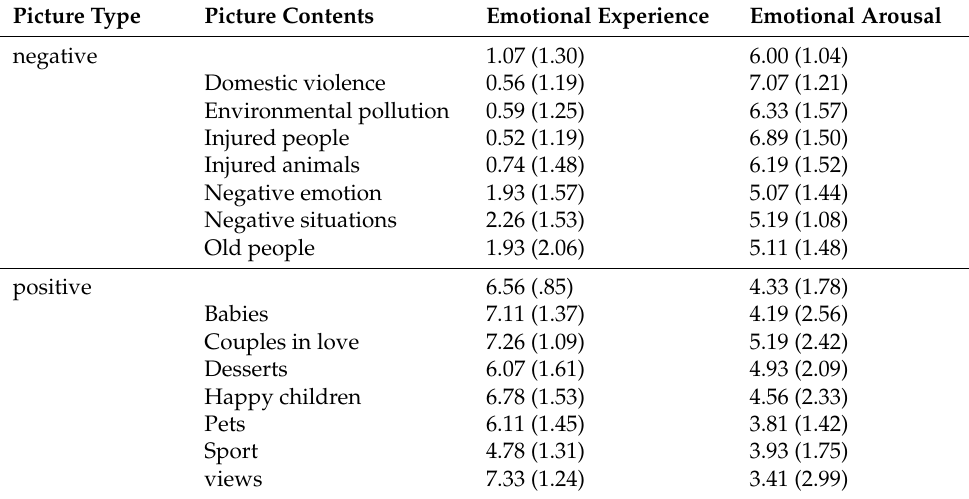
Table 10. Means and standard deviations (SD) of the subjective ratings of emotional experiences and emotional arousal in response to picture type and picture content (N =